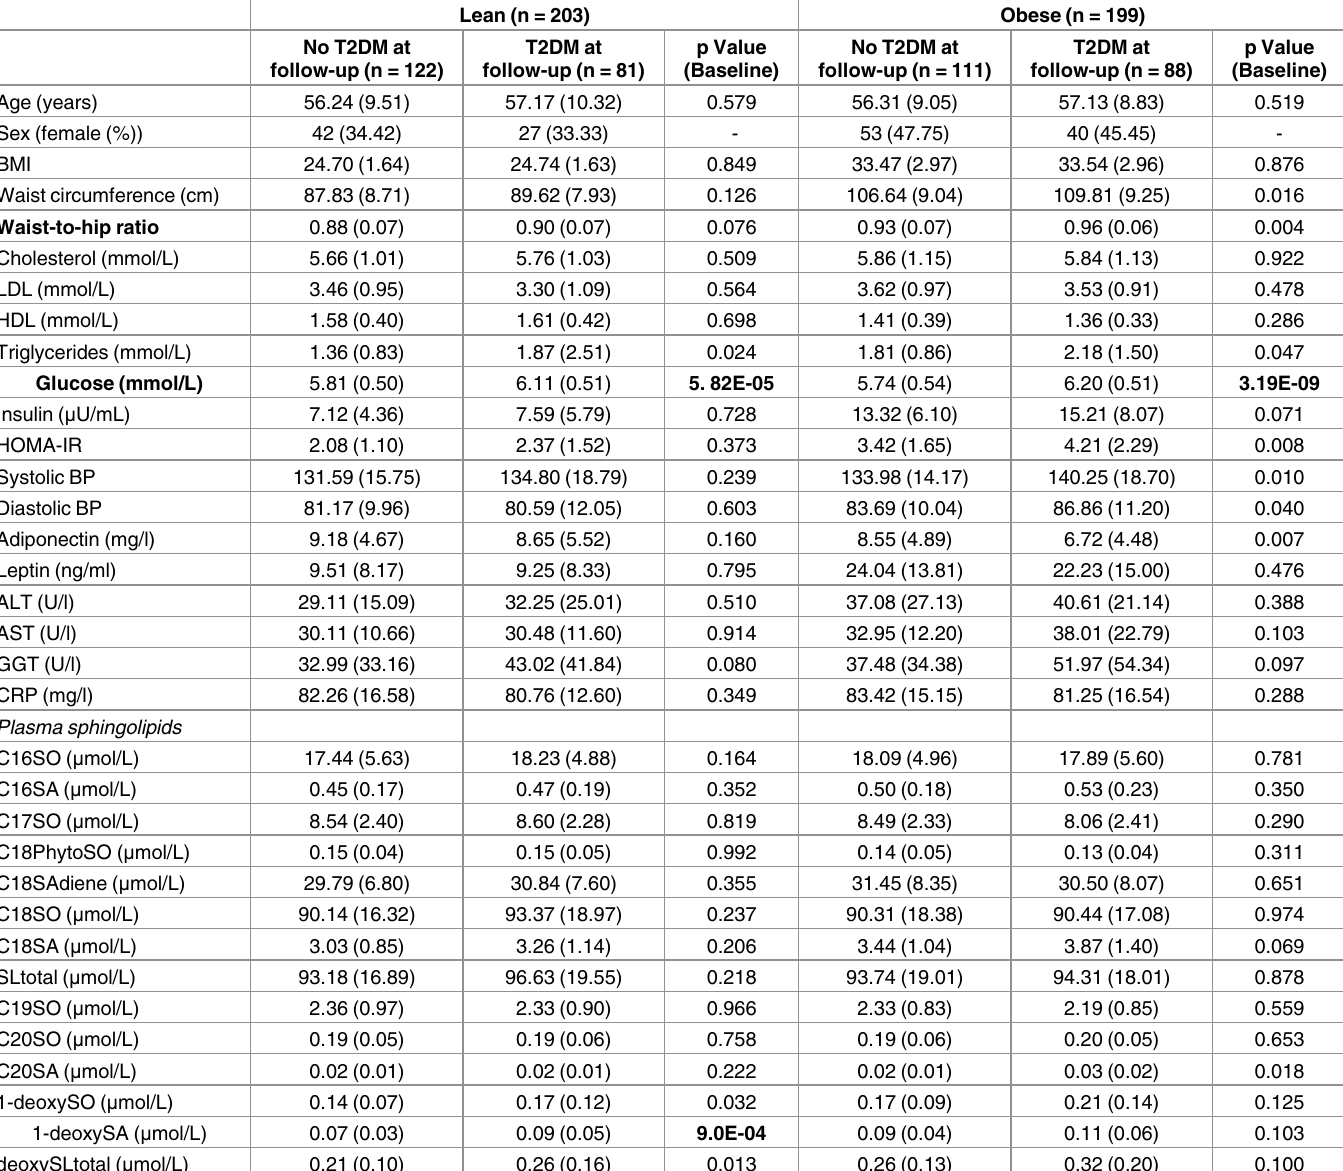
Table 4. Baseline values of clinical variables and sphingolipids levels in the lean-sick and healthy obese group, comparing individuals with inci- dent and non-incident T2DM after 5 years. Lean (n = 203) Obese (n = 199) No T2DM at T2DM at follow-up (n = 122) follow-up (n =